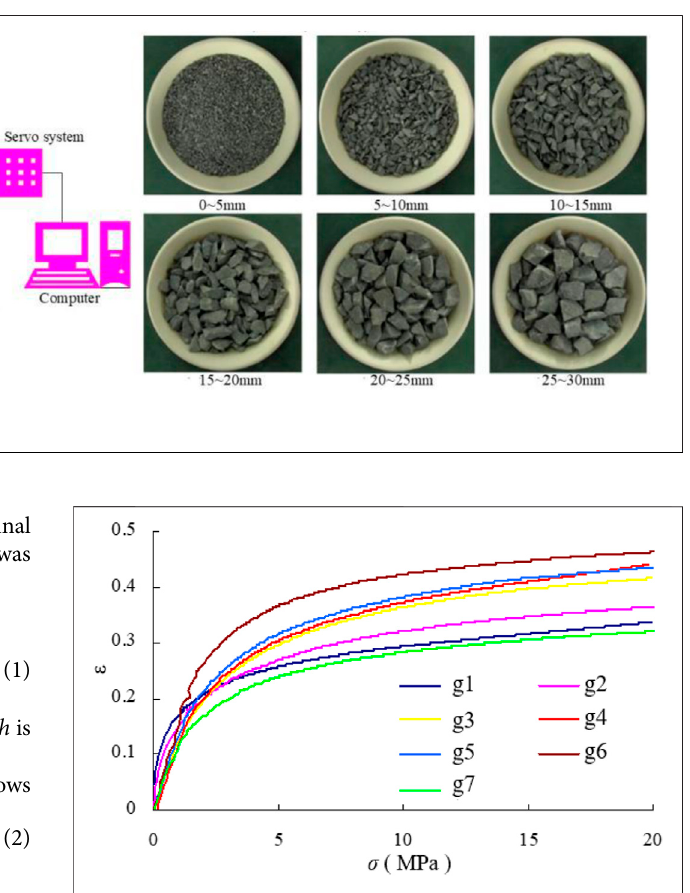
FIGURE 4 | Stress-strain curves of gangue